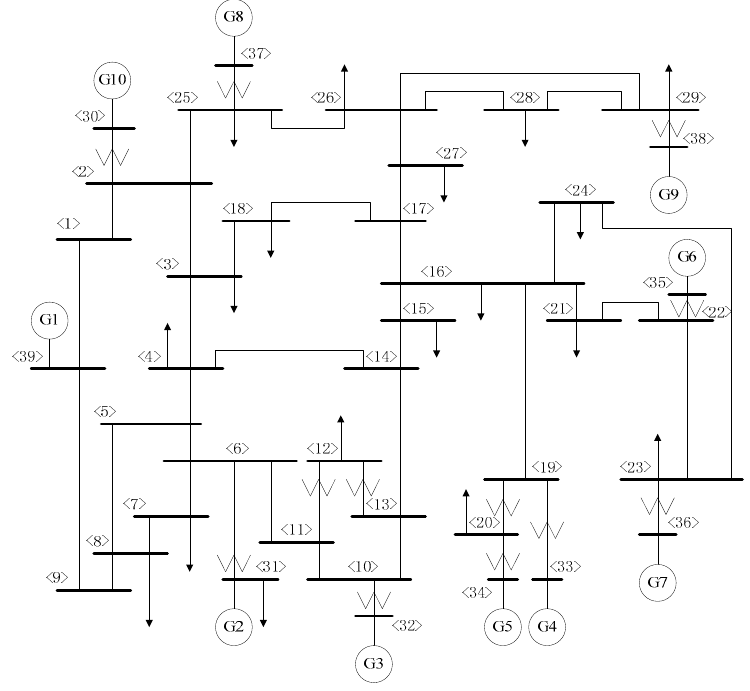
Figure 4. Diagram of the New England 39-bus test system.